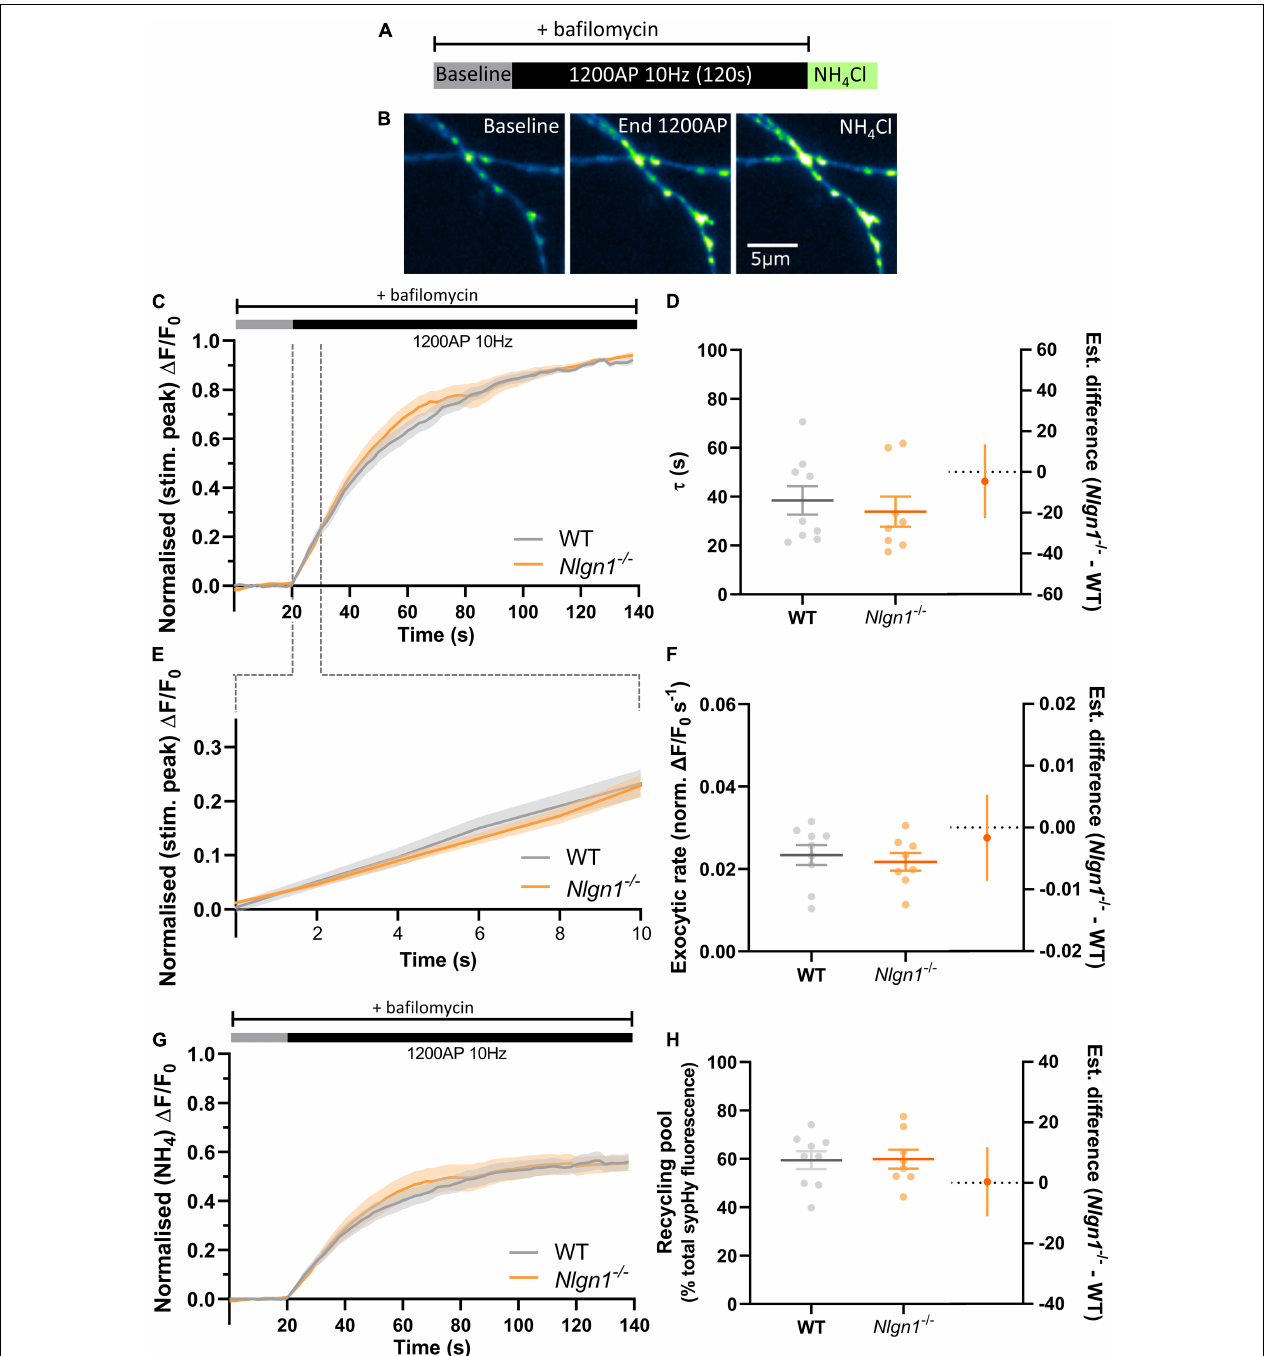
FIGURE 3 | Rate of exocytosis is unchanged in Nlgn1 − / − synapses. Nlgn1 − / − and WT neurons transfected with sypHy were stimulated with 1200 AP (10 Hz) in the presence of bafilomycin to inhibit vesicle reacidification. (A) Overview of experimental paradigm. (B) Representative images of relative sypHy fluorescence at baseline, following 1200 action potentials (end 1200 AP), and following perfusion with NH 4 Cl. Scale bar indicates 5 µ m. Images are false coloured to show relative sypHy fluorescence, with warmer colours indicating increased fluorescence intensity. (C) Time trace of mean ( ± SEM) change in sypHy fluorescence, normalised to peak fluorescence during stimulation. (D) Mean ( ± SEM) exocytosis time constant (tau, s), p = 0.5997. (E) Time trace of mean ( ± SEM) change in sypHy fluorescence during first 10 s of stimulation, normalised to peak fluorescence during stimulation. (F) Mean ( ± SEM) rate of exocytosis ( (cid:49) F/F 0 s − 1 ) as assessed by linear fit over first 10 s of stimulation (from C ), p = 0.6186. (G) Time trace of mean ( ± SEM) change in sypHy fluorescence, normalised to total fluorescence revealed by NH 4 Cl perfusion. (H) Mean ( ± SEM) size of total recycling pool assessed as peak fluorescence during stimulus train, as a % of total sypHy fluorescence revealed by NH 4 Cl, p = 0.9445. (D,F,H) Scatter plots show individual data points. Bars indicate mean ± SEM. Forest plots show estimated difference between genotypes with 95% CI, unpaired t -test. N = 8–9 individual fields of view from independent coverslips.